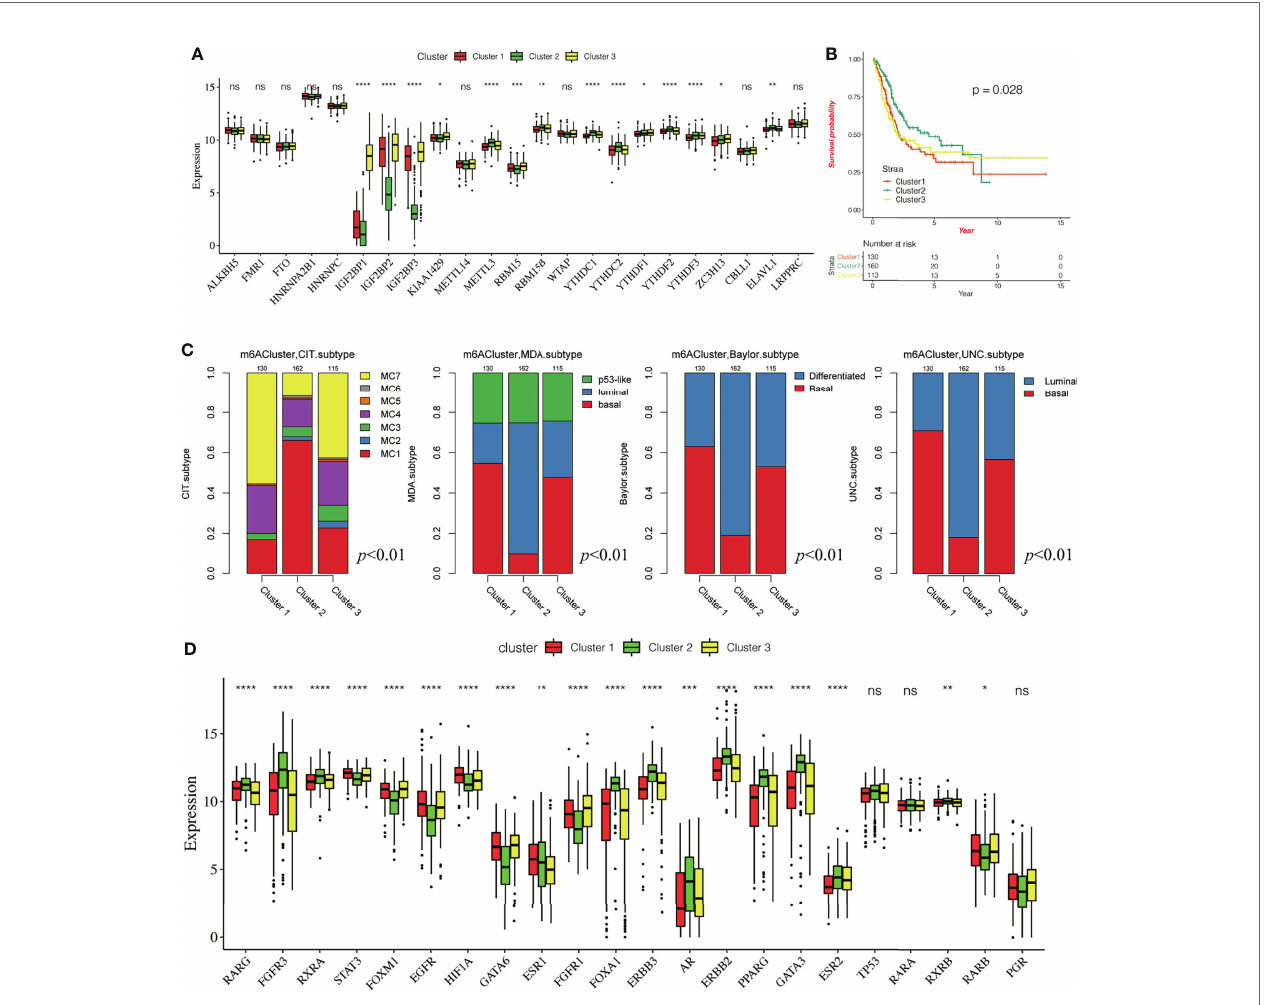
FIGURE 3 | Characteristics of three different methylation patterns of m 6 A. (A) The expression of 23 m 6 A regulatory factors varied among the three different m 6 A modi fi cation patterns. The upper and lower end of the box indicates the quartile range of the value, the lines in the box represents the median value, the black dot represents the abnormal value, and the asterisk represents the statistical p-value, *P < 0.05; **P < 0.01; **P < 0.001, ***P < 0.0001, ****P < 0.0001. (B) The KM curve shows the difference in the effects of the three m 6 A modi fi cation patterns on OS. (C) Comparative analysis of three different m 6 A modi fi cation patterns and molecular typing of bladder cancer, including Bayol classi fi cation, MDA typing, CIT Curie typing, and UNC typing. (D) The upper and lower ends of the box represent the quartile range of values, the lines in the box represent the median value, and the black dots represent the abnormal values. The asterisk represents the statistical p-value, *P < 0.05; **P < 0.01; *P < 0.001, ***P < 0.0001, ****P < 0.0001, ns P >